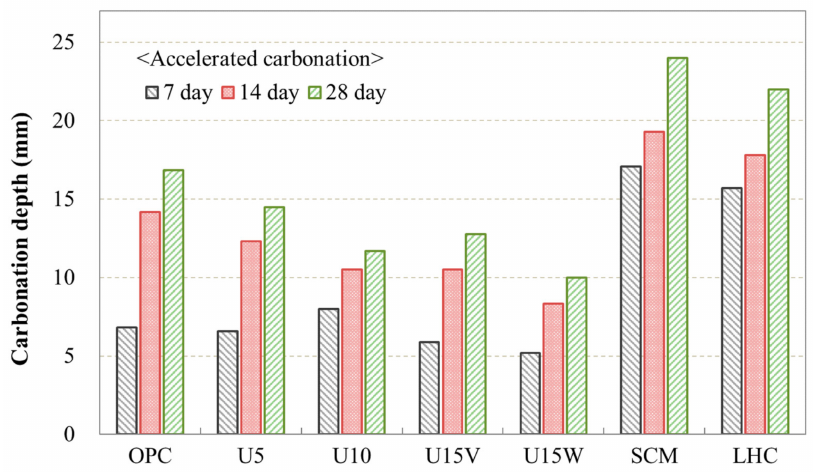
Figure 5. Carbonation depths of the concrete